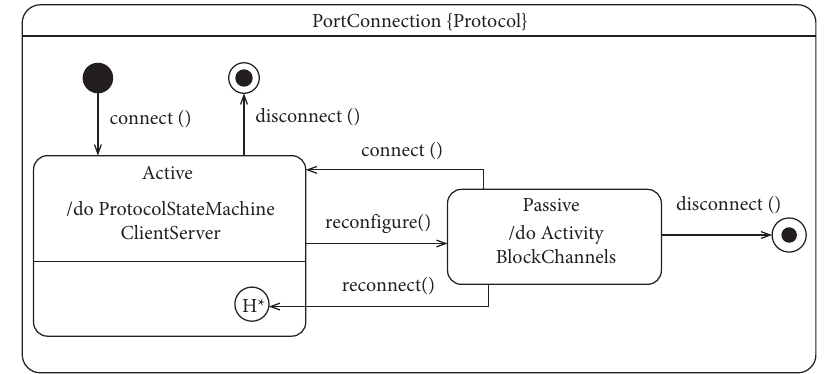
Figure 8: ReconfigurablePort/Export connection protocol.